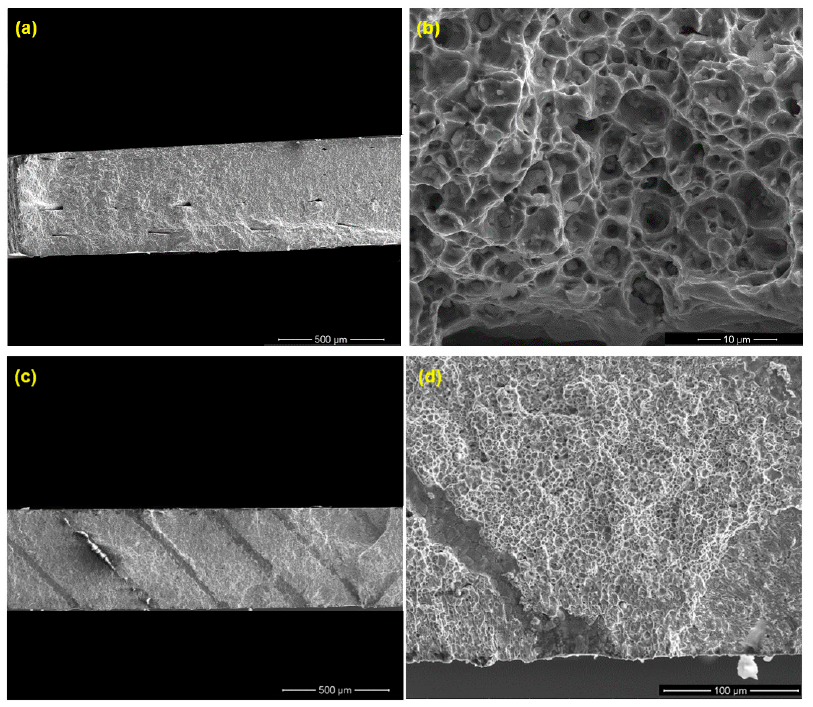
Figure 15. SEM image of the fracture surfaces after ultrasonic bending fatigue testing for ( a , b ) H and ( c , d ) V test specimens. ( a , c , d ) Layer interfacial/track boundary voids at the fracture surfaces; ( b ) fracture surface of as-sintered parts showing small-sized defects (pores and inclusions).